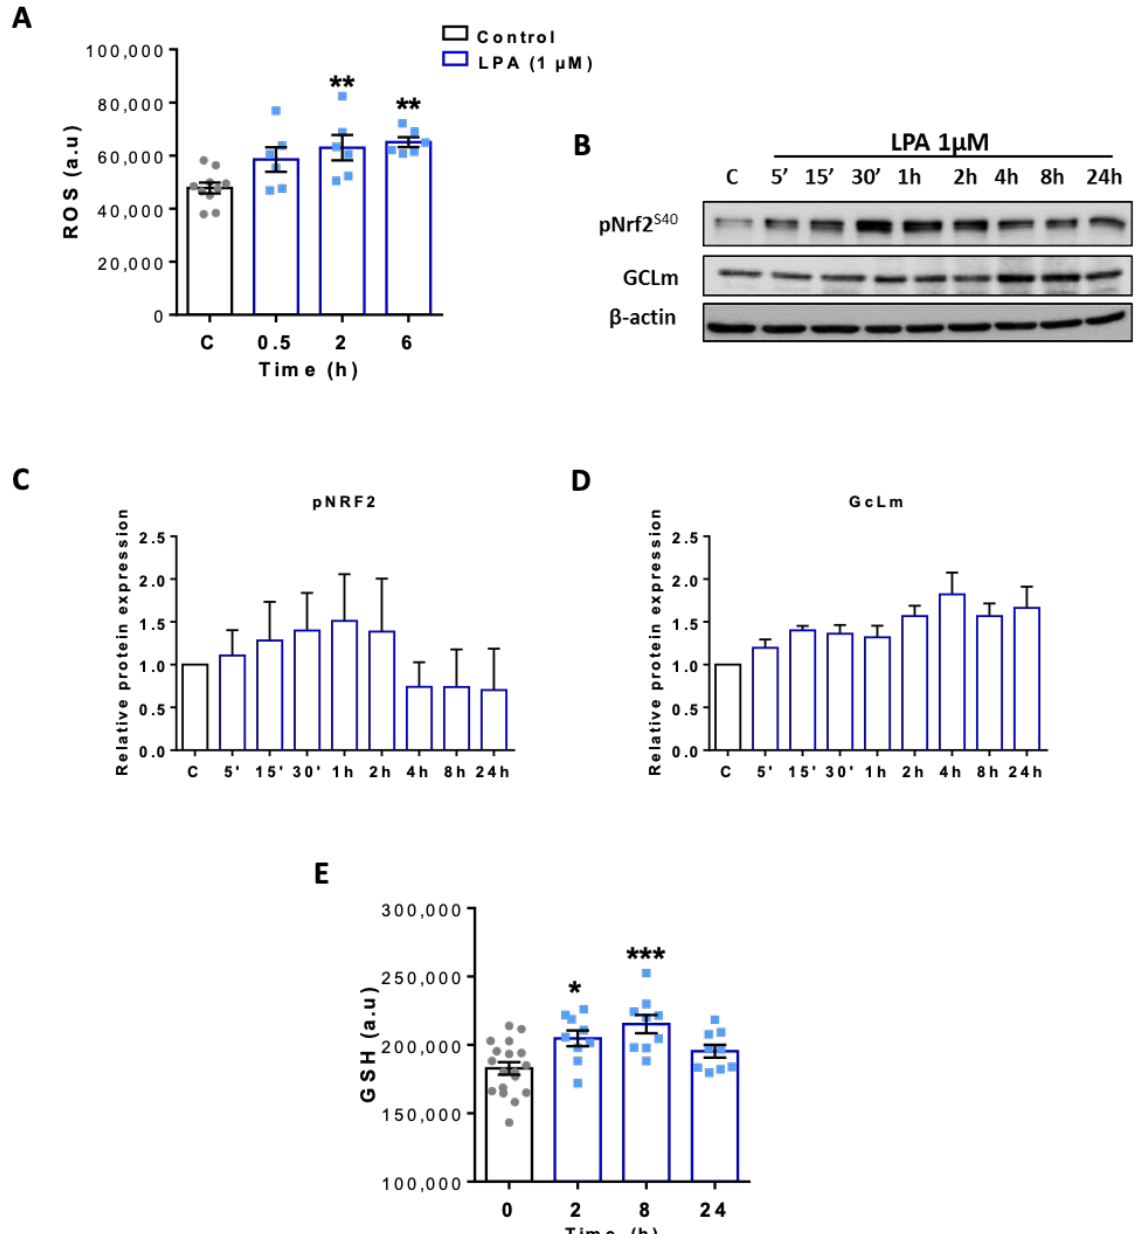
Figure 7. Characterization of the antioxidant response in LPA treated BV-2 cells. ( A ) Reactive oxygen species (ROS) of control and LPA (1 µ M) treated cells was quantified using the ROS-ID ® Total ROS Detection kit (a.u. arbitrary units). ( B ) Immunoblot analysis of phospho Nrf2 (Ser40) and GCLm upon treatment with LPA. One representative blot out of three is shown. β -actin was used as loading control. ( C , D ) Densitometric analysis relative to β -actin from three independent immunoblot experiments are presented. ( E ) Glutathione (GSH) concentration of LPA (1 µ M) treated cells was quantified with GSH-Glo Assay kit and compared with controls in three independent experiments. Results are presented as mean values ± SEM (* p < 0.05, ** p < 0.01, *** p < 0.001, compared to control; one-way ANOVA with Bonferroni correction).